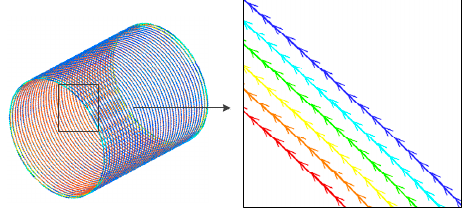
Figure 12. 3D fluid field distribution in the air-gap.